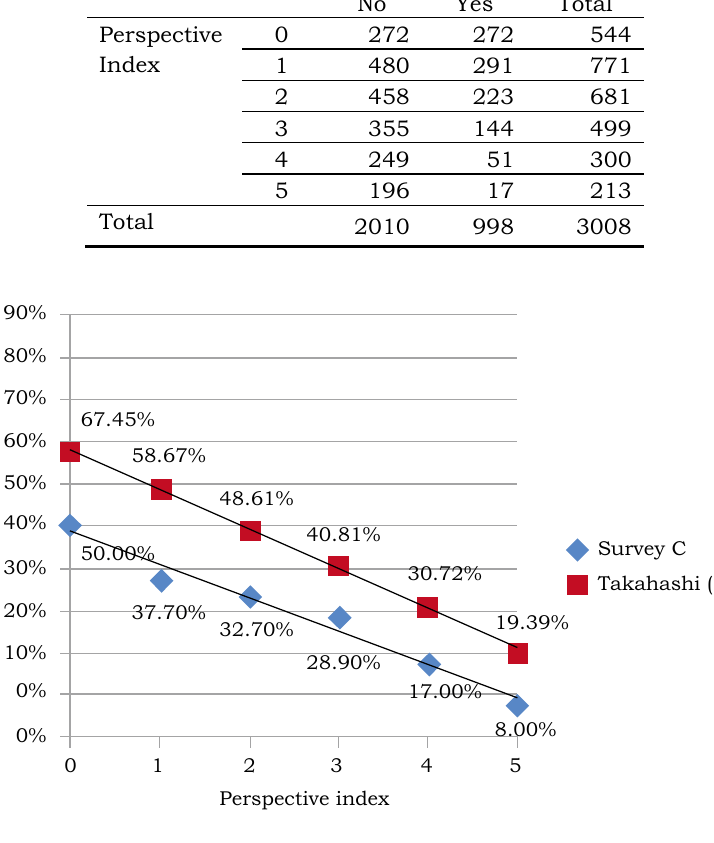
Figure 2. Perspective index and turnover candidate